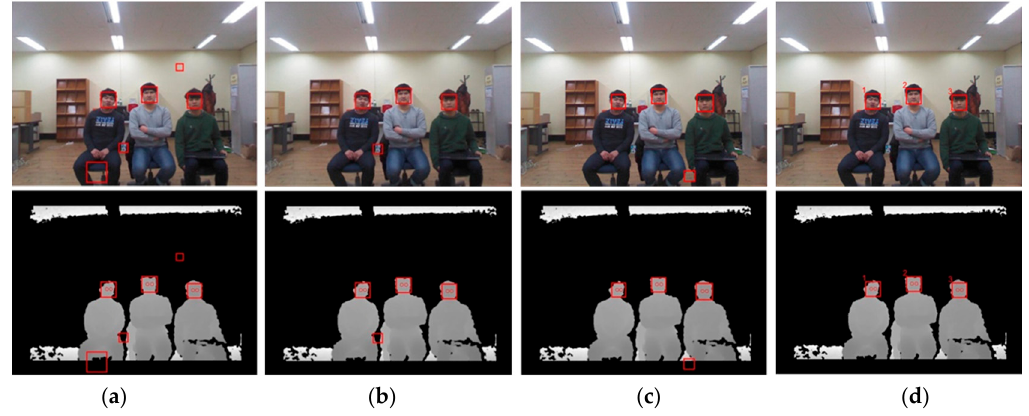
Figure 10. Comparing the detection accuracy of the proposed and benchmark algorithms at a distance of 3.5 m from RGB and depth cameras (top: RGB image; bottom: depth image): ( a ) Algorithm 1; ( b ) Algorithm 2; ( c ) Algorithm 3; and ( d ) proposed algorithm.